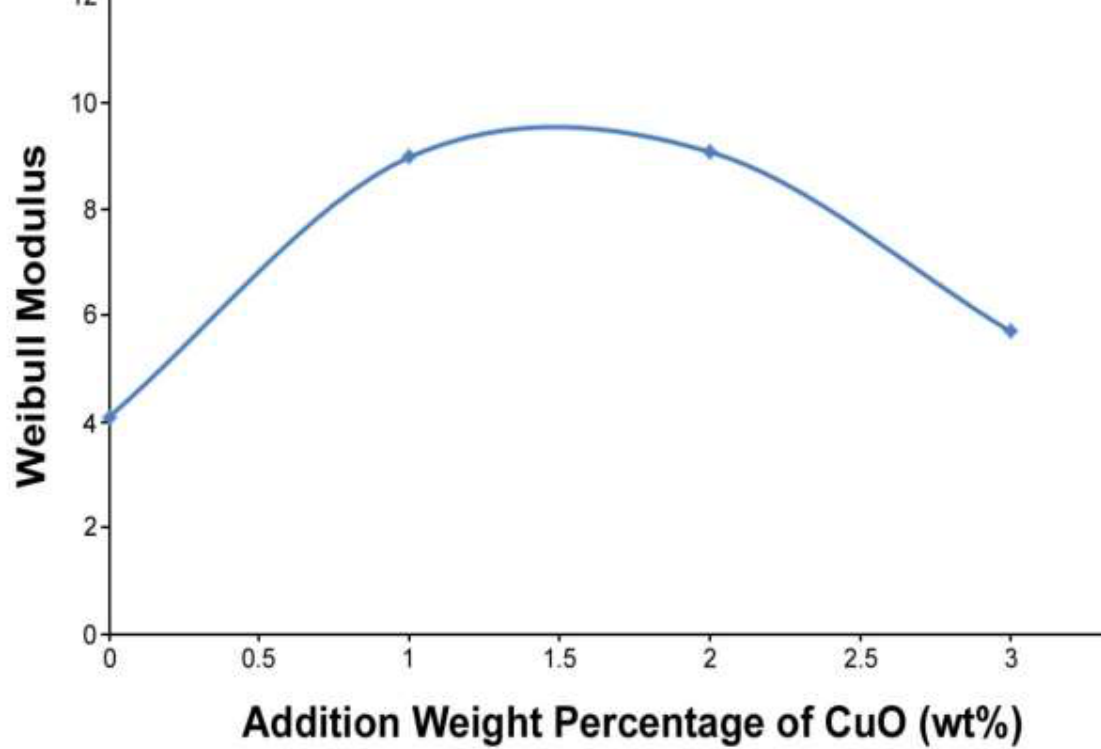
Figure 7: The relationship between Weibull modulus and addition weight percentage of